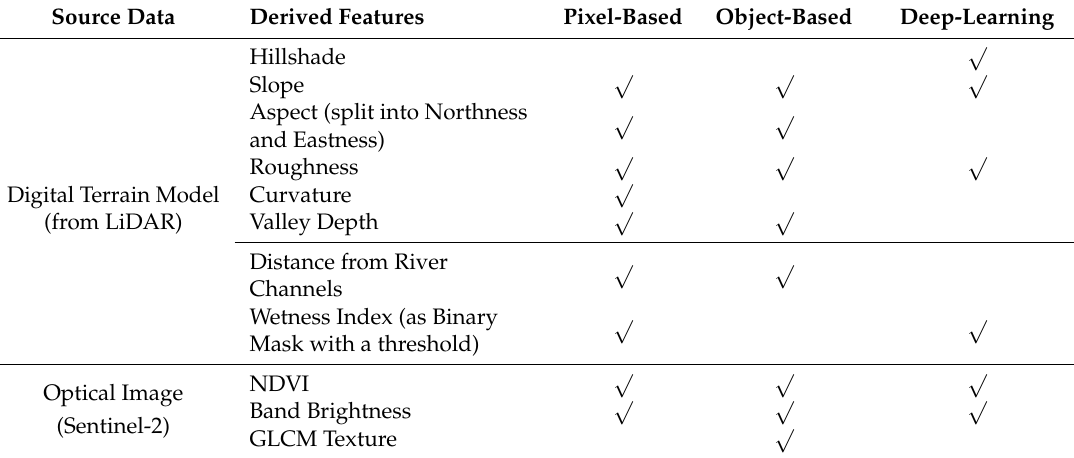
Table 3. List of derived features (at multiple resolution ranging from 2 m to 16 m) used for mapping landslide in this